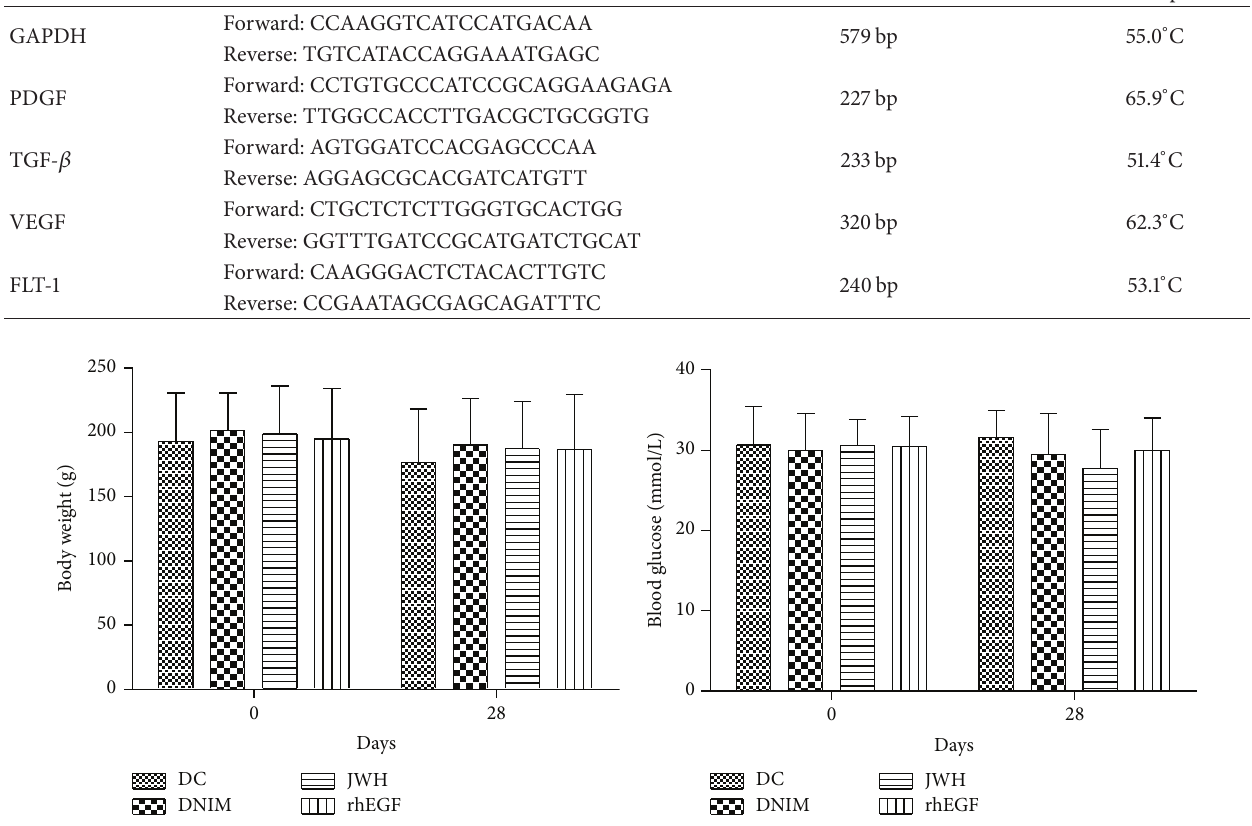
Figure 1: Results of the body weight and plasma glucose of the rats. (a) The body weight on day 0 and day 28 after administration ( 𝑥 ± 𝑆 , 𝑛 = 10 ). (b) The blood glucose on day 0 and day 28 after administration ( 𝑥±𝑆 , 𝑛 = 10 ). There are no significant differences between all groups ( 𝑃 > 0.05